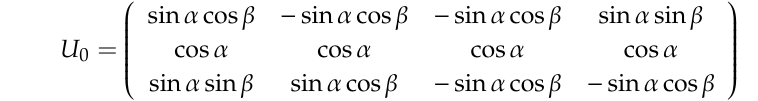
Figure 9. Configuration of six-orthogonal flywheels. The installation matrix is as follows: